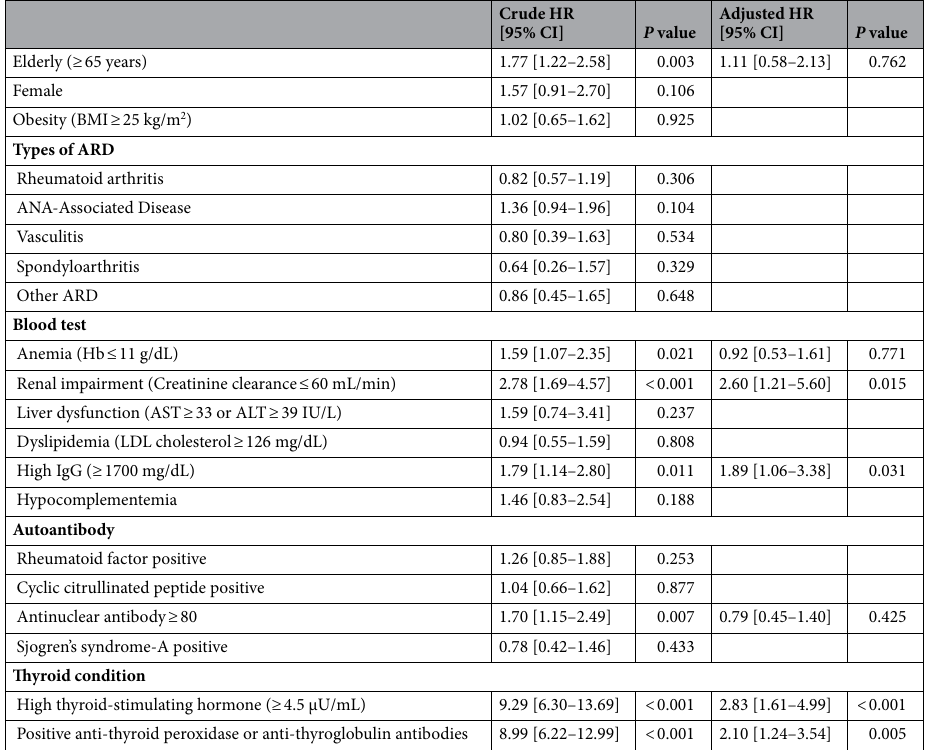
Table 6. Risk factors for hypothyroidism requiring treatment during follow-up in ARD patients. HR hazard ratio, CI confidence interval, BMI body mass index, ANA antinuclear antibody, Hb hemoglobin.